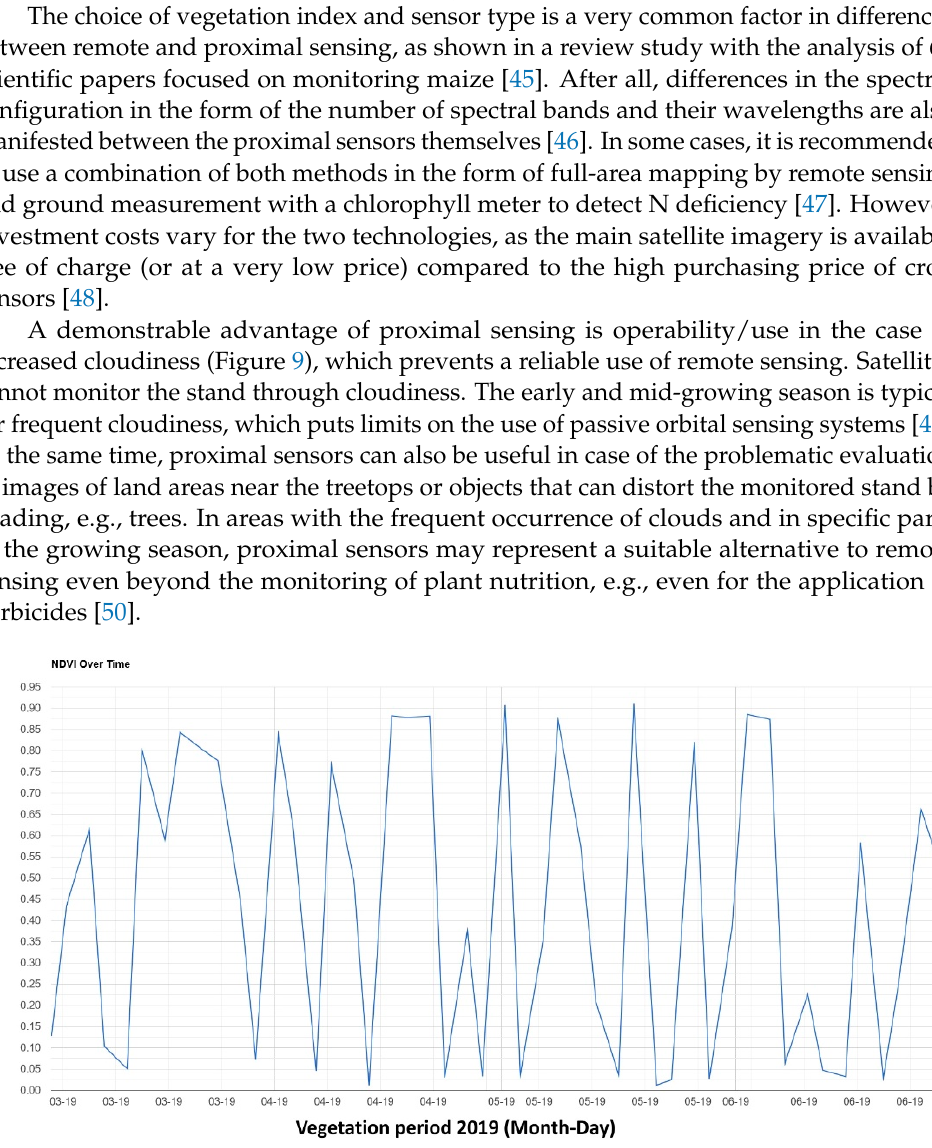
Figure 9. Overview of the cloud occurrence of Sentinel-2 images in the vegetation season 2019 (March–June) by indication of NDVI for locality Zdounky. Low NDVI values represent the occurrence of clouds in the observed scene (source: Google Earth Engine).